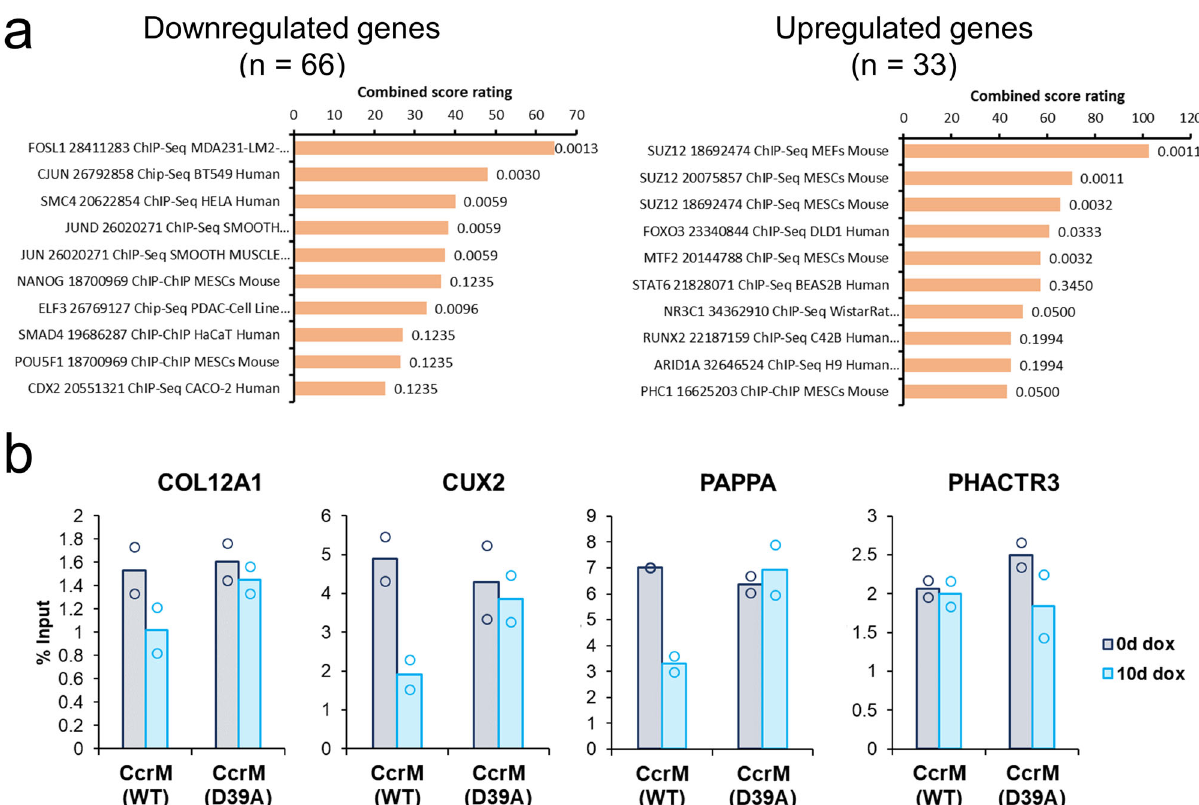
Fig. 5 Analysis of m6dA-dependent regulated genes. a Gene set enrichment analysis of signi fi cantly down- or upregulated genes utilizing the ChEA 2022 results available through the Enrichr tool (https://maayanlab.cloud/Enrichr/). b Change of H3K27me3 in the promoter regions of upregulated genes. Shown are H3K27me3 ChIP-qPCR results in two biological repeats (indicated by the dots), each of them based on three technical repeats of the qPCR. Three out of four tested genes ( COL12A1, CUX2, PAPPA ) showed a CcrM-dependent decline in H3K27me3. The qPCR amplicons, genomic ChIP-seq pro fi les and qPCR results of control experiments for the HOXA11-AS and CCND2-AS1 loci are shown in Suppl. Fig. 6. The bars indicate the average values of two experimental